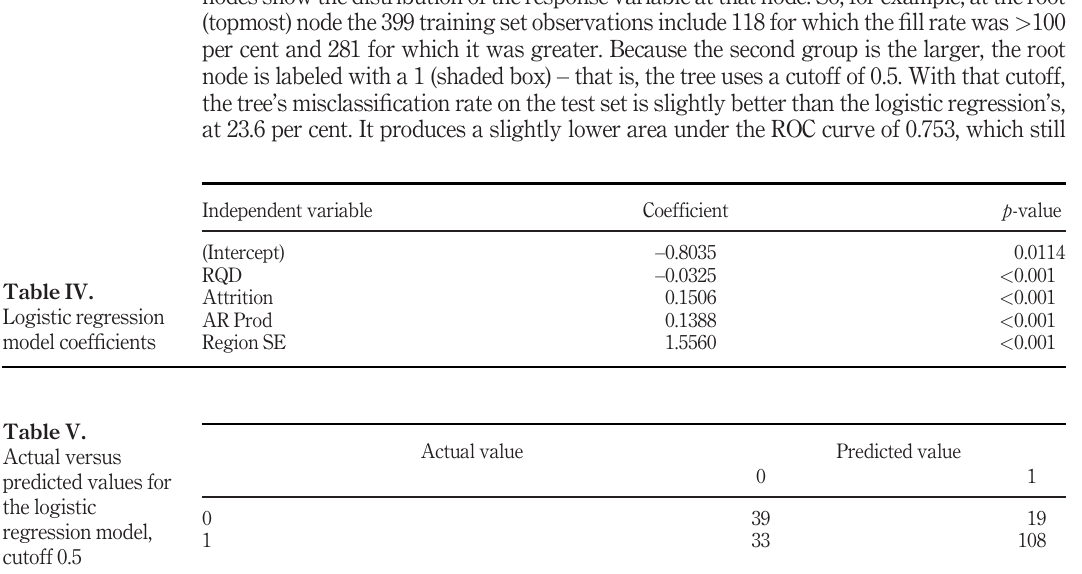
predicted values for the logistic regression model, cutoff 0.5